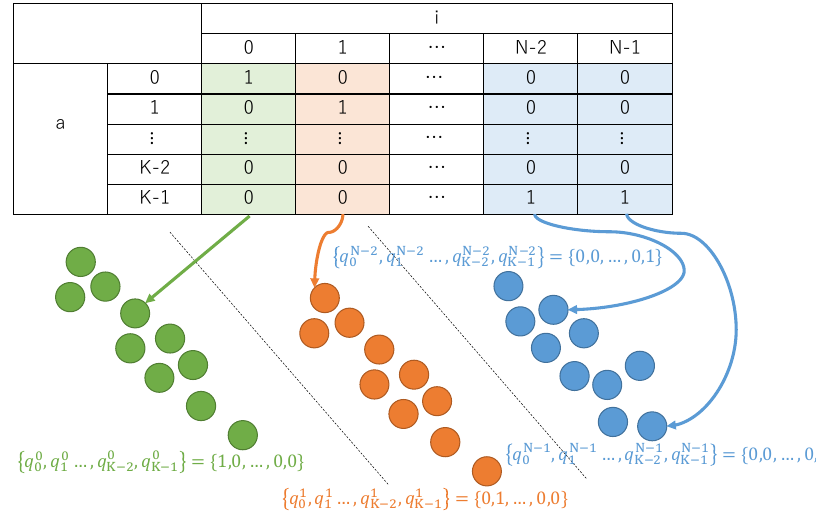
Figure 1. An overview of one-hot